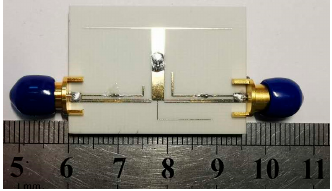
Figure 12. Filter responses of Case G ( C F = 1.5 pF, C S = 100 pF, C T = 1.4 pF).